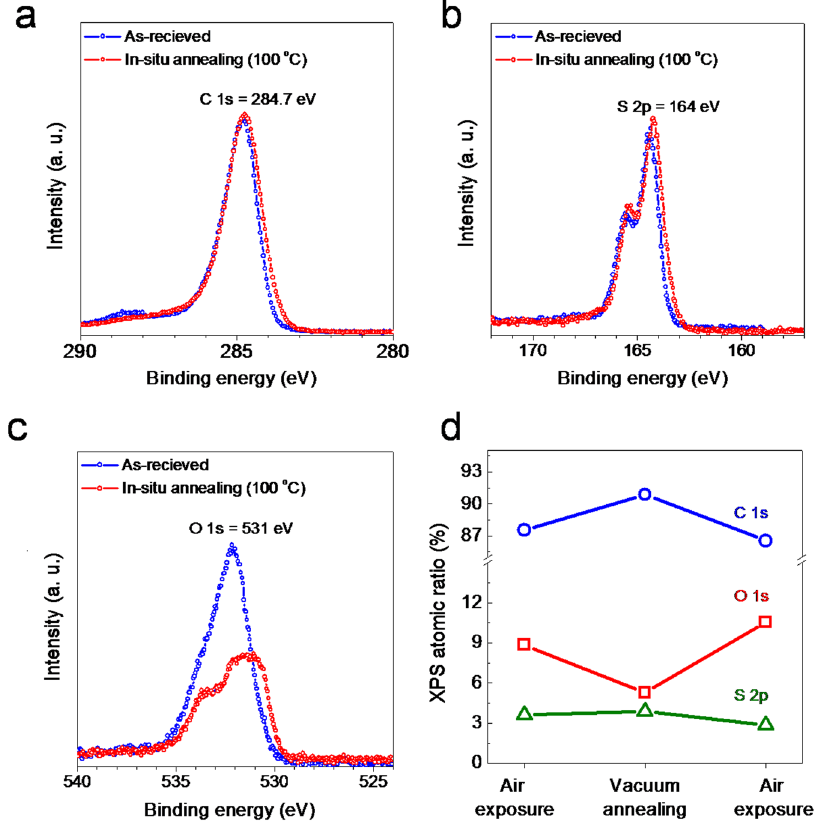
Figure 3. XPS analysis of the PDPP3T. ( a ) C 1s core level spectra. ( b ) S 2p core level spectra. ( c ) O 1s core level spectra. Blue circle: as-received. Red circle: vacuum annealing at 100 °C. ( d ) XPS atomic ratio variations for